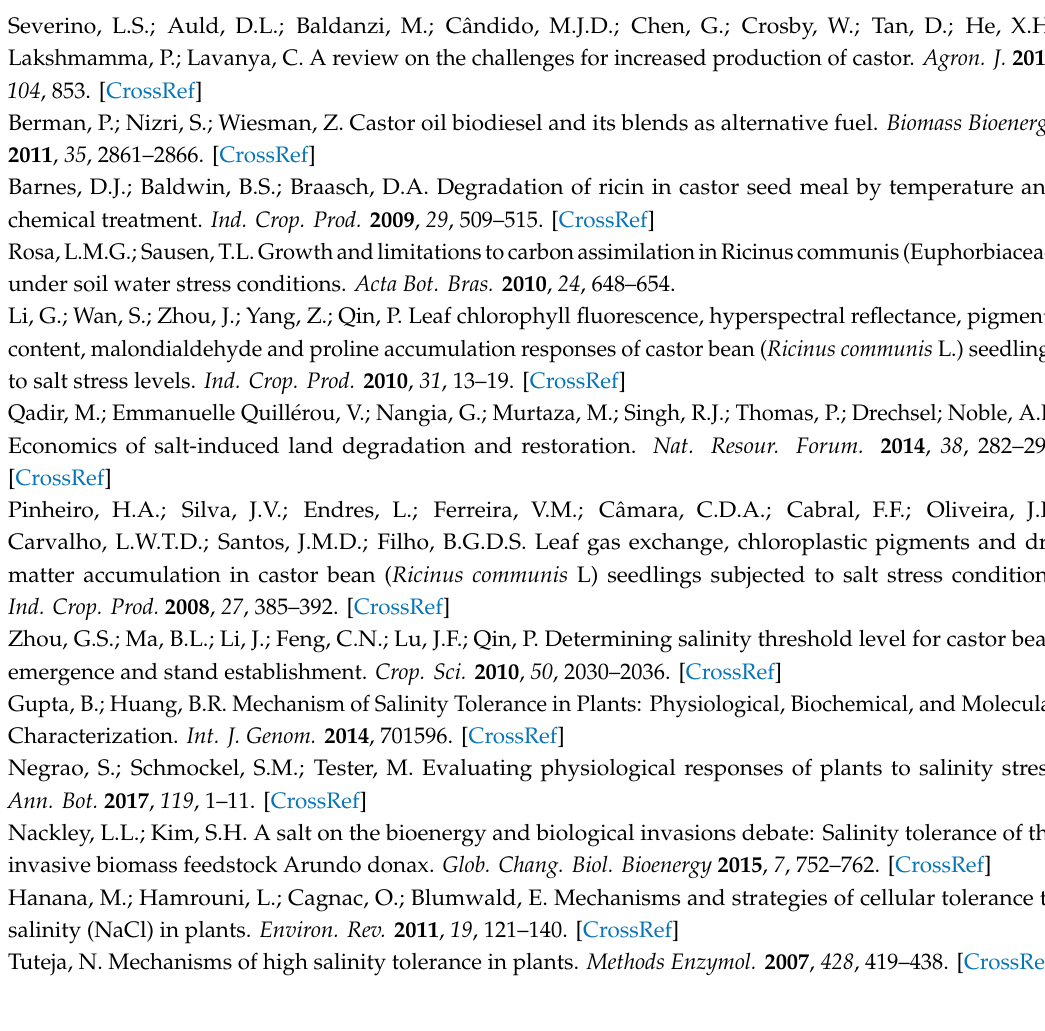
Table S1: F values from ANOVA for plant height, stem diameter, leaf area related to NaCl, GA 3 and their interactions of castor bean seedlings, Table S2: F values from ANOVA for dry matter related to NaCl, GA 3 and their interactions of castor bean seedlings, Table S3: F values from ANOVA for SOD, POD and CAT activity, soluble protein and proline content related to NaCl, GA 3 and their interactions of castor bean seedlings. Author Contributions: G.Z. (Guisheng Zhou) applied for the funding, administrated the project and designed the study. W.Z and G.L. conducted the experiments. X.J. prepared the data, undertook the analysis and wrote the manuscript. G.Z. (Guanglong Zhu) and G.F., N.E.A.N. and I.A. provided direction and supervised the work. All authors contributed to editing the